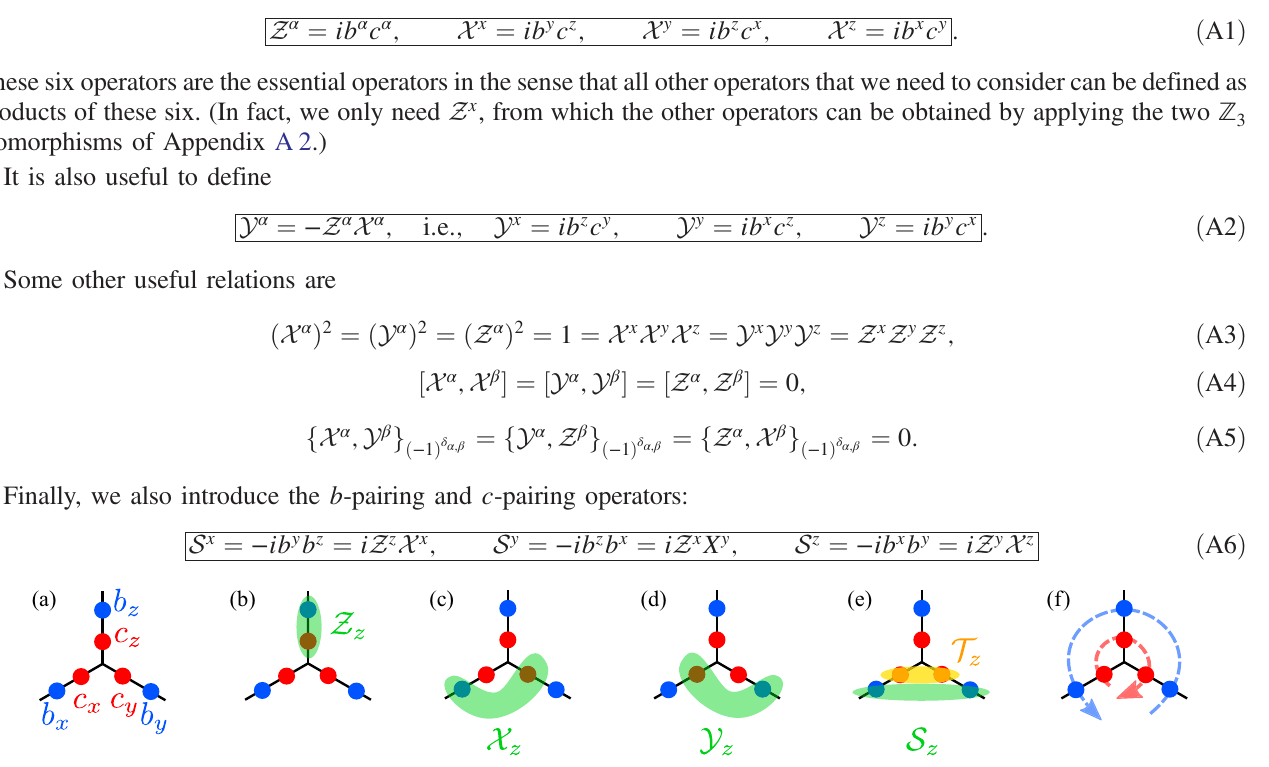
FIG. 12. (a) Six Majoranas with even-parity condition ib x b y b z c x c y c z ¼ 1 representing a four-state system. (b) Z z operator. (c) X z operator. (d) Y z operator. (e) Chiral S z and T z operators. In panel (f), we show that, using the S α and T α operators, one can generate the